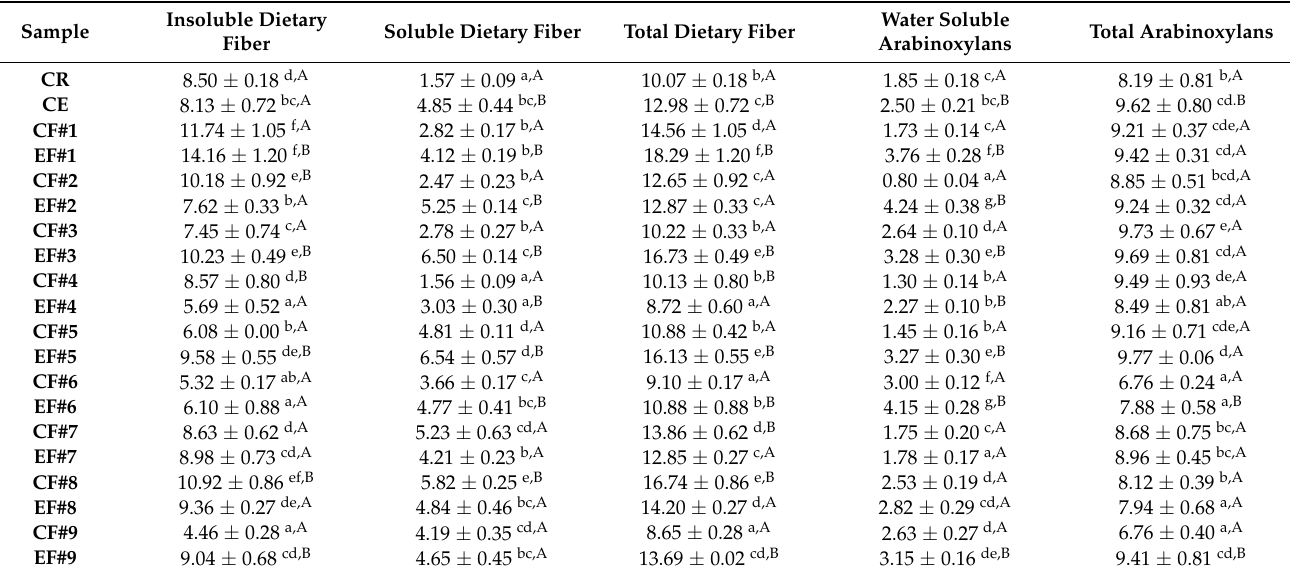
Table 2. Dietary fiber (insoluble, soluble, and total) and arabinoxylan (total and water-soluble) content in fortified rice–chickpea flours (raw and extruded) (g/100 g, fresh weight) (mean ±